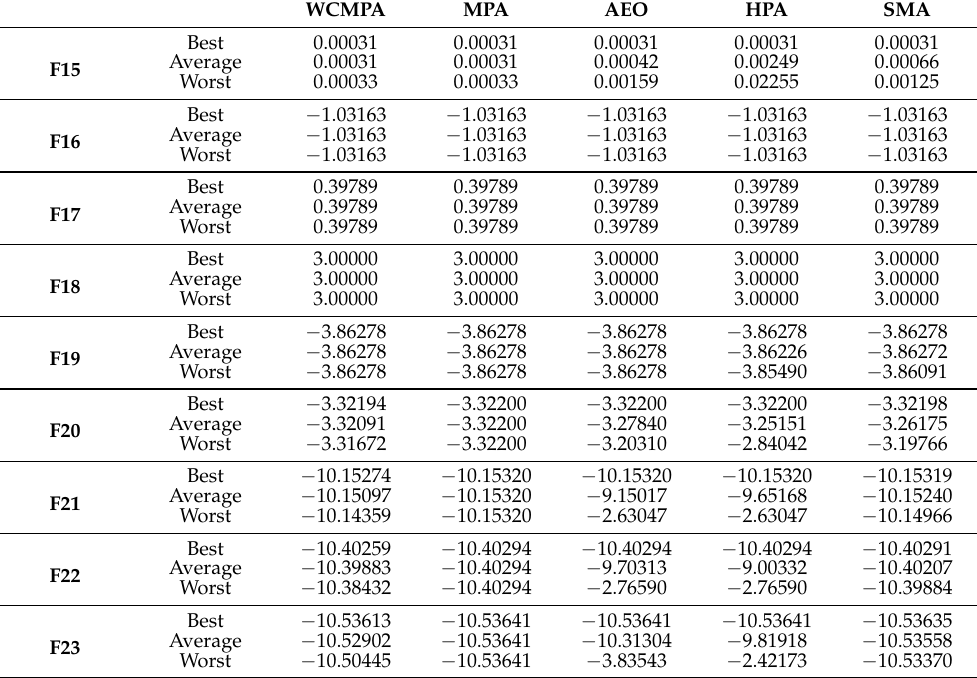
Table 4. Parametric test values for composite benchmark